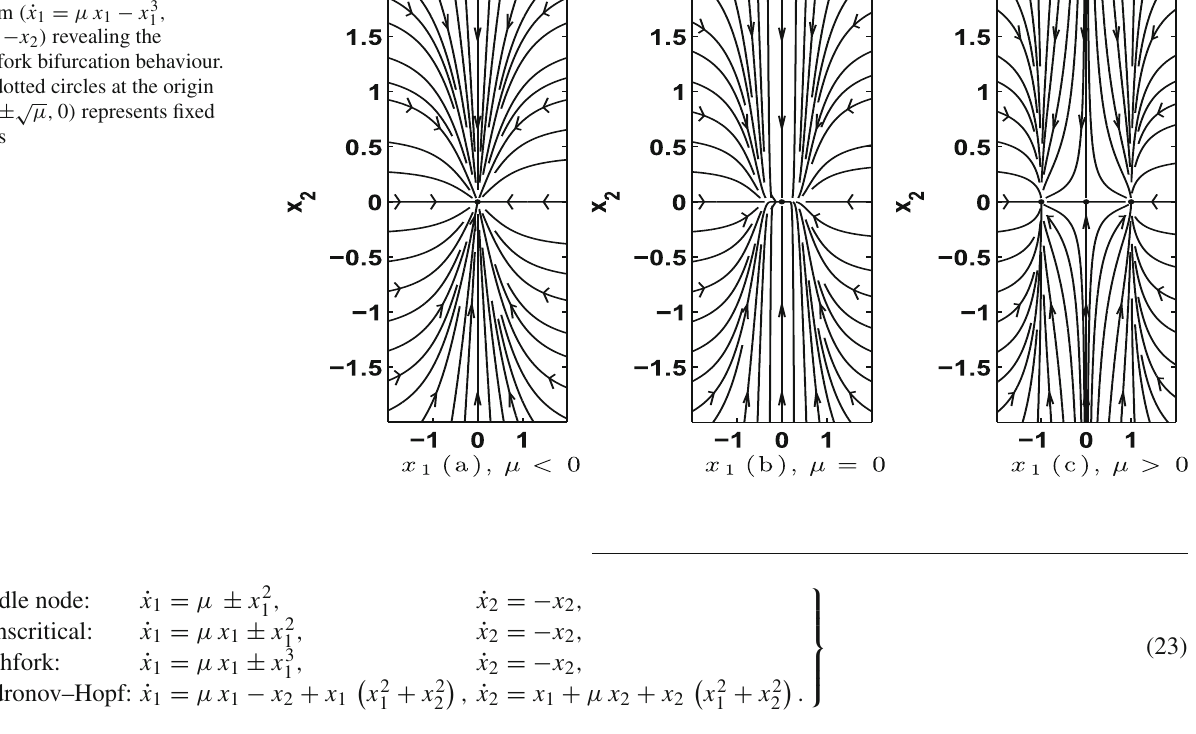
Fig. 2 Phase portraits for the system ( ˙ x 1 = μ x 1 − x 3 ˙ x = − x ) revealing the 2 2 pitchfork bifurcation behaviour. The dotted circles at the origin ±√ μ, 0 ) represents fixed and (